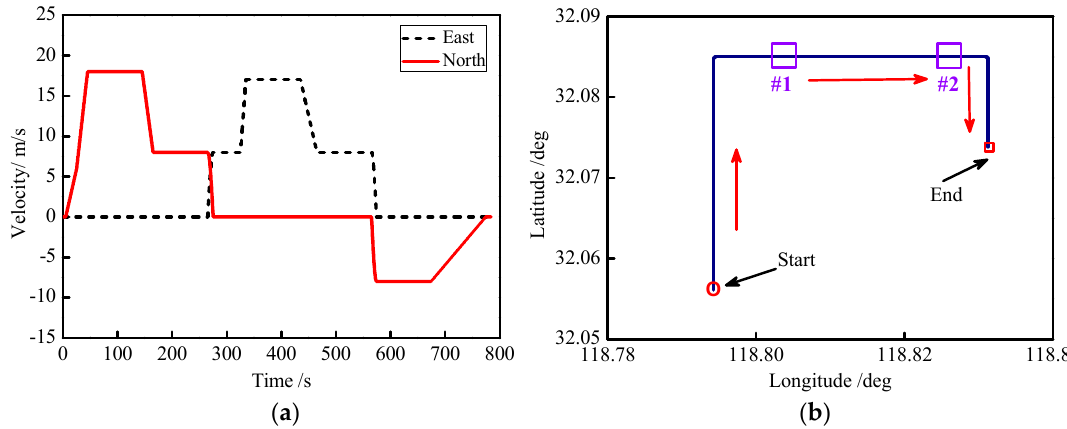
Figure 6. Curves of vehicle motion: ( a ) east and north vehicle velocities; ( b ) curves of the moving trajectories.